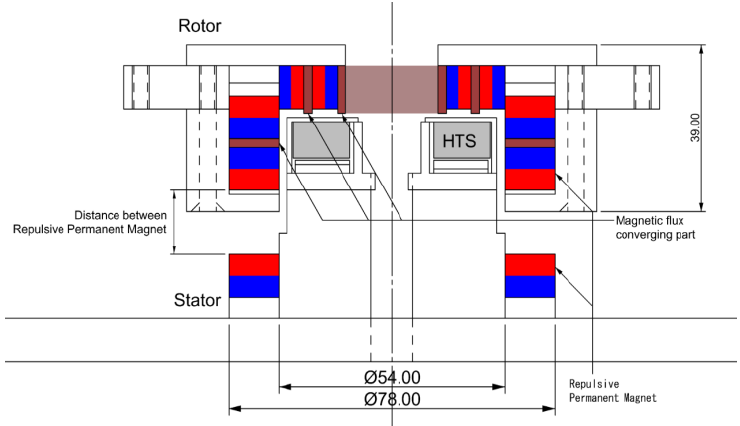
Figure 2. HTS magnet configuration with repulsive permanent magnet.